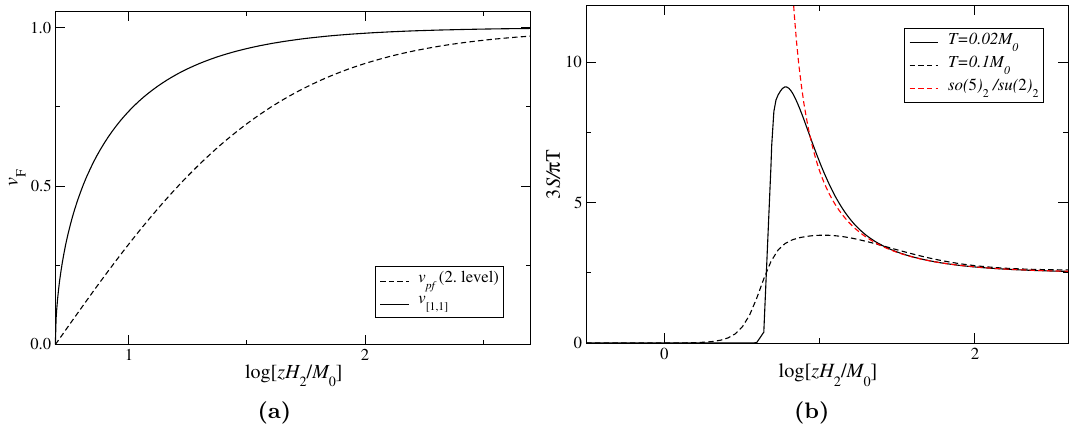
Figure 5 . (a) Fermi velocities of the [1 ; 1]-solitons and second level parafermion modes as a function of the (cid:12)eld zH 2 =M 0 for p 0 = 2+1 = 3, H 1 (cid:17) 0 at zero temperature. For large (cid:12)elds, H 2 > H 2 ;(cid:14) , both Fermi velocities approach 1 leading to the asymptotic result for the low-temperature entropy (2.30). (b) Entropy obtained from numerical solution of the TBA equations (2.12) for p 0 = 2 + 1 = 3 and H 1 (cid:17) 0 as a function of the (cid:12)eld zH 2 =M 0 for T = 0 : 02 M 0 . For (cid:12)elds large compared to the [1 ; 1]-soliton mass, zH 2 (cid:29) 2 M 0 , the entropy approaches the expected analytical value (2.30) for a (cid:12)eld theory with a free bosonic sector and a Z =Z parafermion sector propagating SO(5) Nf SU(2) Nf with velocities v and v (2) , respectively (full red line). For magnetic (cid:12)elds zH 2 < 2 M 0 and [1 ; 1] pf temperature T (cid:28) 2 M 0 the entropy is that of a dilute gas of non-interacting quasi-particles with degenerate internal degree of freedom due to the